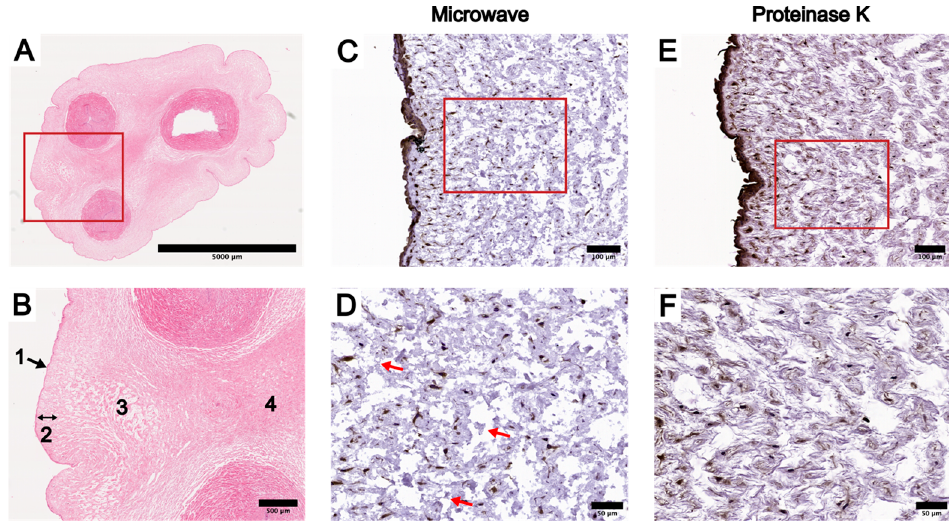
Figure 2. Comparison of HLA-ABC staining results in term umbilical cord (UC) cross-sections using microwave and proteinase K antigen retrieval (AR) protocols. ( A ) Hematoxylin and eosin stain of a term UC cross-section showing the outer amniotic epithelium (AE), three umbilical vessels, and the Wharton’s Jelly (WJ) surrounding the vessels. ( B ) Enlarged image of the boxed region in ( A ): 1, AE; 2, subamniotic WJ (SAWJ) located between the AE and the intermediate WJ (IWJ); 3, more loosely structured IWJ with visible clefts in the matrix; 4, dense perivascular WJ (PVWJ) between the two vessels where the matrix structure is more compact. ( C ) IHC staining of HLA-ABC in term UC cross- sections using the microwave AR protocol, focusing on the AE and SAWJ. ( D ) Boxed region of ( C ) at higher magnification. Red arrows: visible disruption of IWJ after microwave AR in comparison to proteinase K AR. ( E ) IHC staining of HLA-ABC using the proteinase K AR protocol in term UC cross-sections, focusing on the AE and SAWJ. ( F ) Boxed region of ( E ) at higher magnification. Scale bars: A = 5000 µm; B = 500 µm; C and E = 100 µm; D and F = 50 µm.